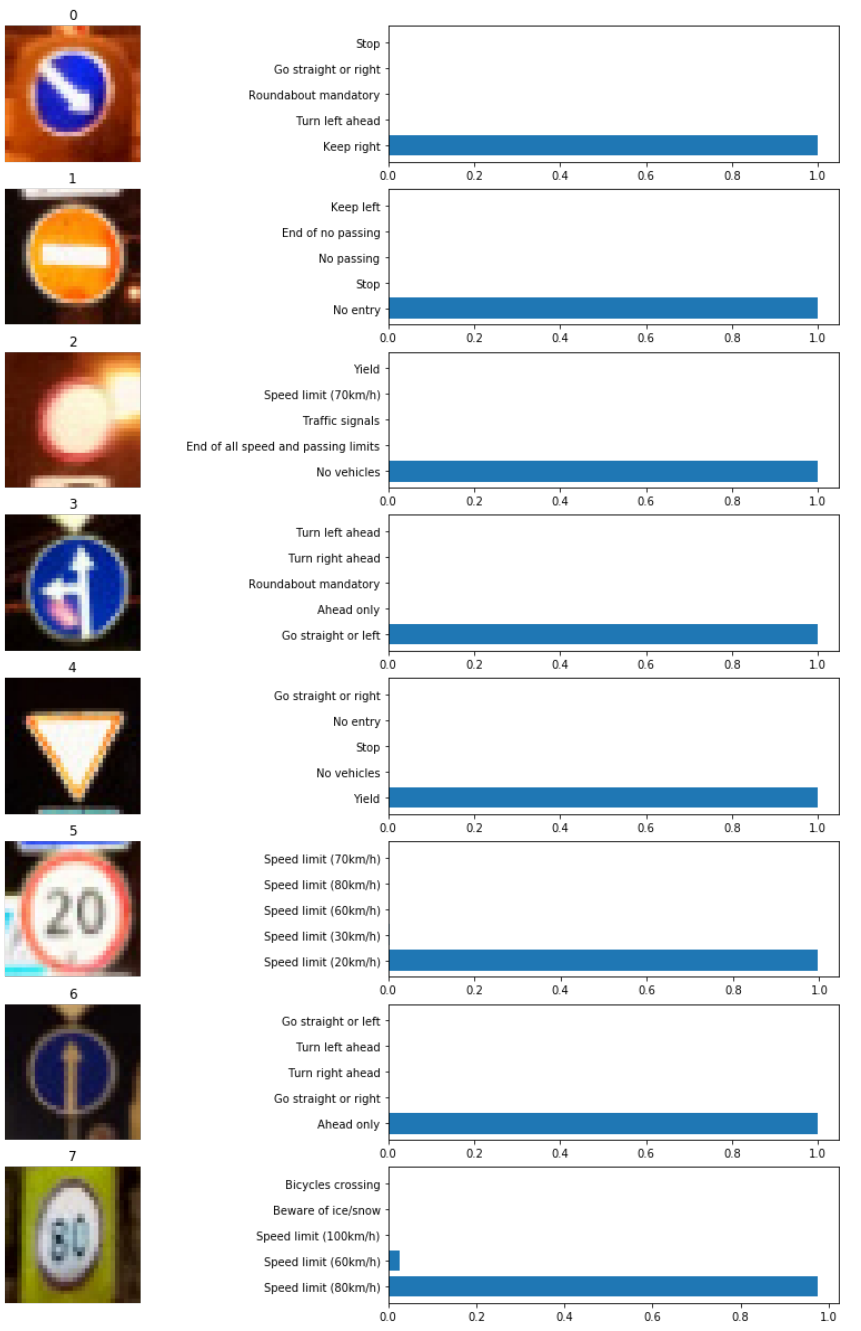
ffi c sign test images in the network testing Figure 14. The recognition results of traffic sign test images in the network testing stage. Figure 14. The recognition results of tra